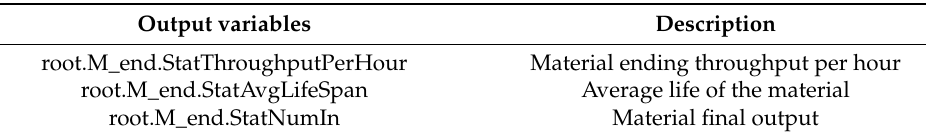
Table 7. Experiment output variables.